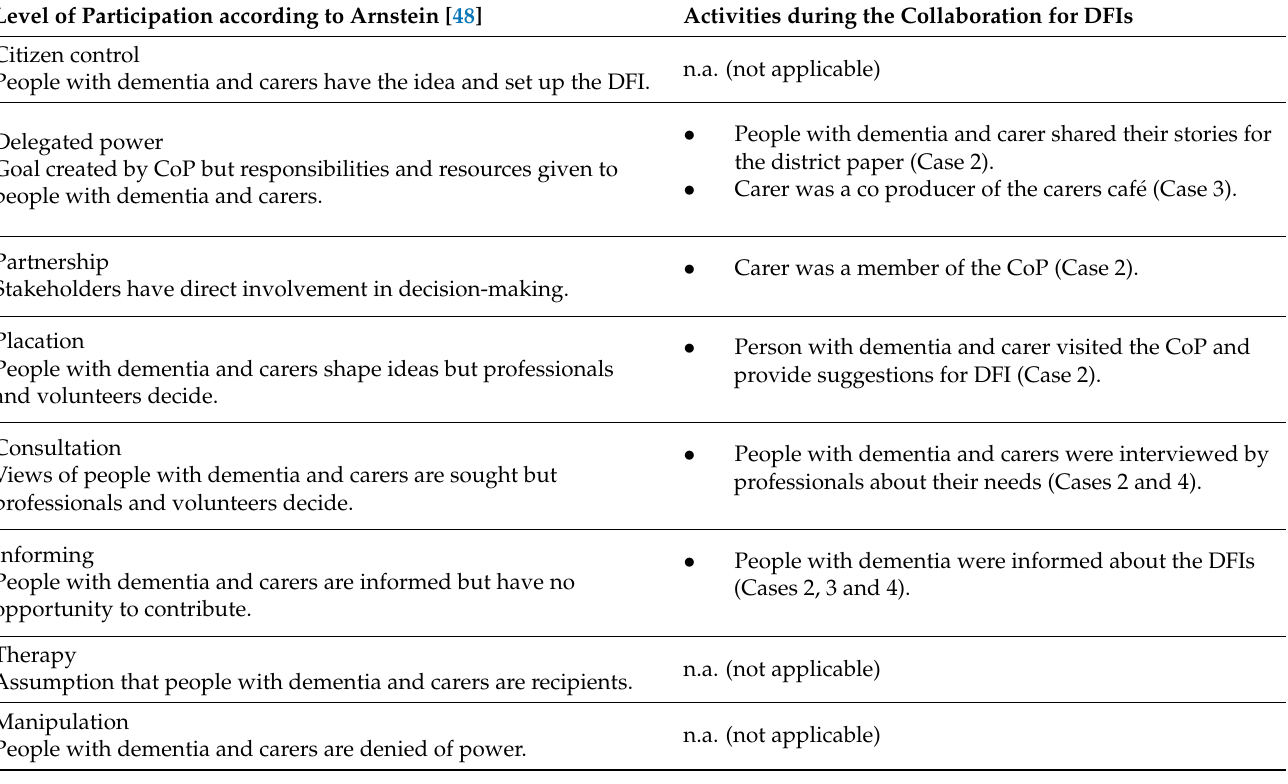
Table 3. Levels of participation of people with dementia and their carers during the collaboration for DFIs using the typology of